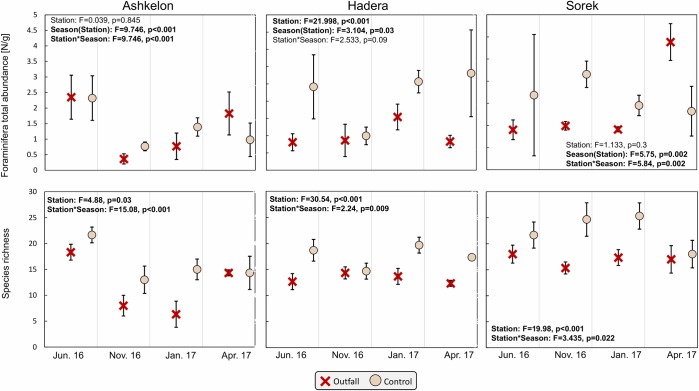
Abundance richness indexes.Foraminiferal total abundance (top) from June 2016-April 2017, calculated from the number of individuals per sample (N) divided by the sample's dry weight (grams). Species richness (bottom), calculated by the number of species in each sample. The X and circles represent the averages of the outfall and control respectably. Solid lines represent the standard deviation of triplicate samples. Two-way ANOVA was performed for each index at each site; the results (statistic F and probability P-value) are presented on each diagram. Significant differences are presented in bold.